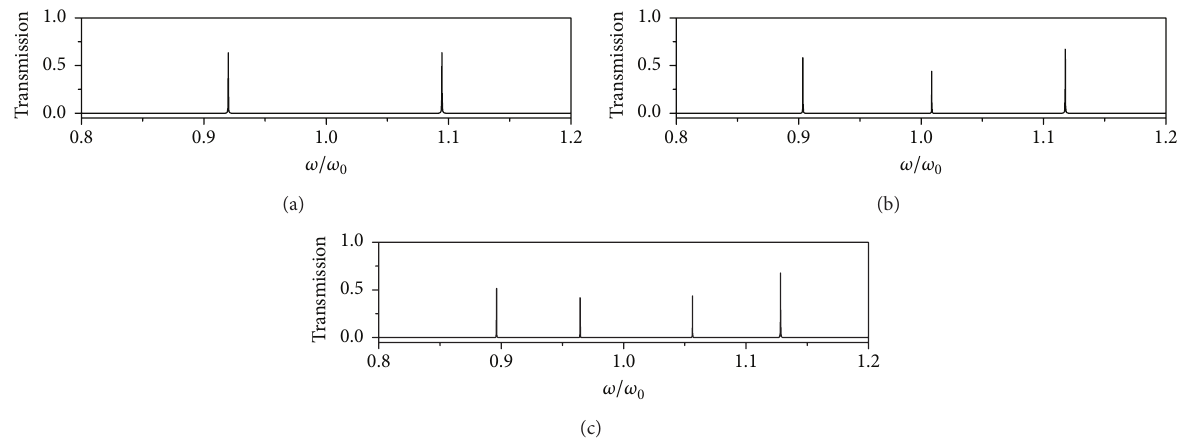
Figure 7: The quantum transmissivity for QW structure (𝐵𝐴) 6 (𝐵𝐵𝐴𝐵𝐵) 𝑛 (𝐴𝐵) 6 with 𝑛 𝑏 = 2 . 45 + 𝑖 0 . 0001. (a) 𝑛 = 1, (b) 𝑛 = 2, and (c) 𝑛 = 3.